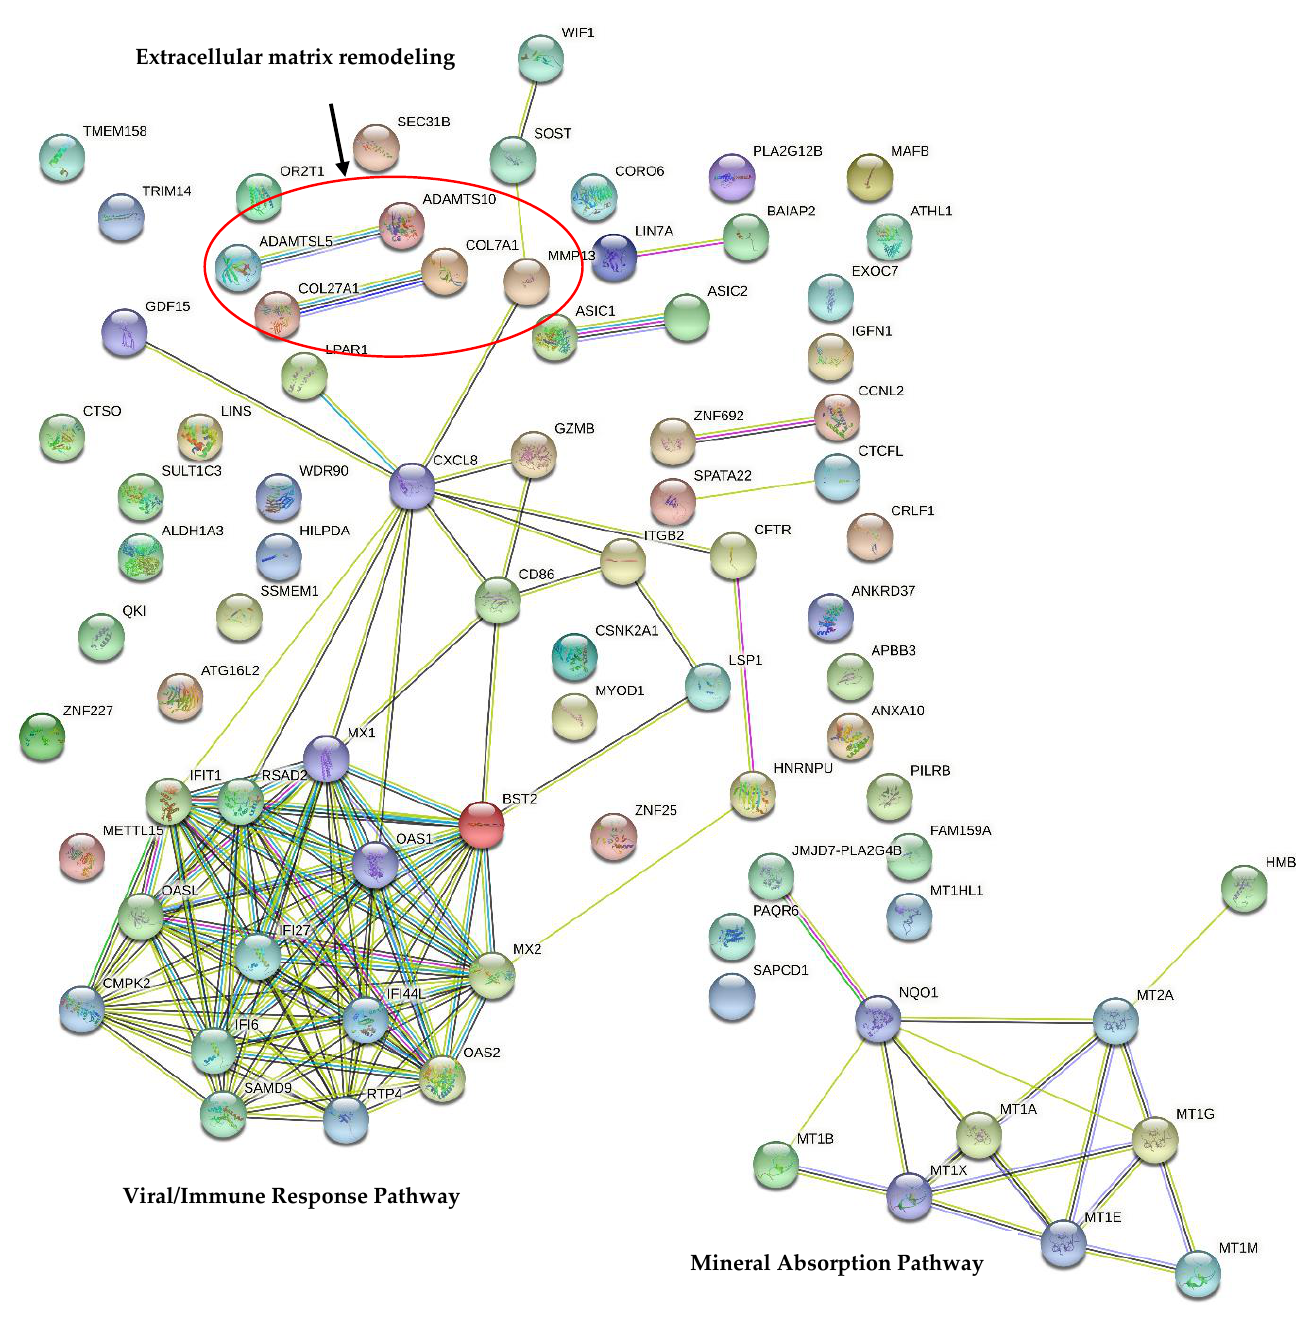
Figure 9. The STRING network of gene–gene interactions in Saos-2 cells exposed to the rough sur- faces (Ra = 1 µ m) of Y-TZP discs for 96 h (STRING database version 11.5). A list of all differentially expressed genes in Saos-2 cells exposed to the rough surfaces of Y-TZP discs for 96 h (FC ≥ |1.5, |f-value ≤ |0.01) (Supplementary Table S1) was injected into STRING database v11.5. The 2 sig- nificantly enriched KEGG pathways (determined using the DAVID database) are represented in bold. Legend: Network nodes represent proteins, edges represent protein–protein associations (red line: the presence of fusion evidence; green line: neighborhood evidence; blue line: co-occurrence evidence; purple line: experimental evidence; yellow line: text mining evidence; light blue line: database evidence; black line: co-expression